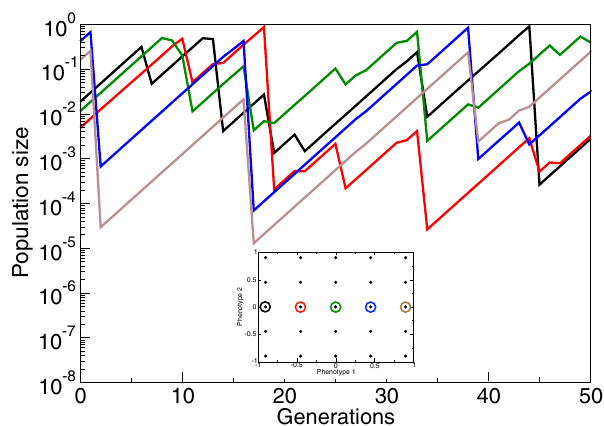
Fig. 5 The number of species as a function of the exponent β . Data are shown for λ = 1.2, σ α = 0.5 and three different dimensions of phenotype space, d = 1 (squares), d = 2 (circles), and d = 3 (diamonds). Species are counted after 10 7 generation and after merging the populations of similar phenotypes using a merging distance of Δ x species = 10 − 1 (see description in main text). Note that the level of diversity shown for small β -values corresponds to the diversity evolving with stable equilibrium ecological dynamics.